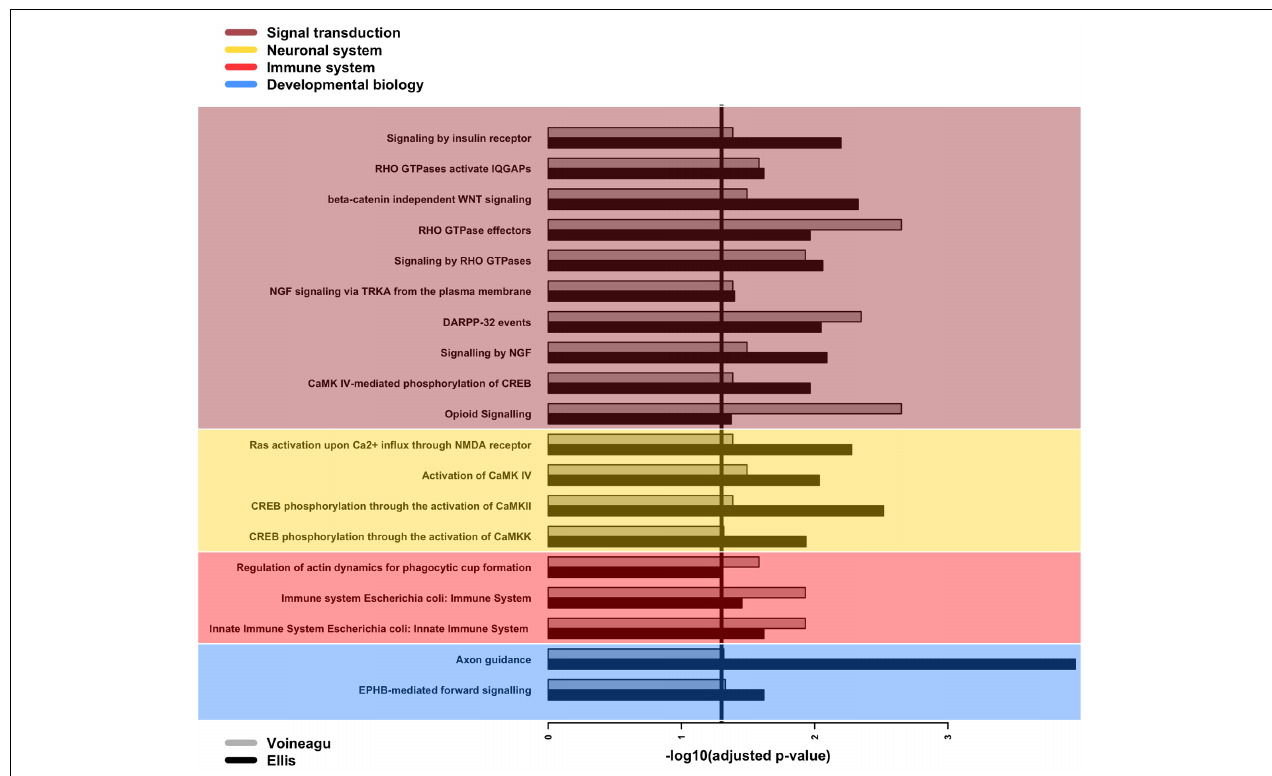
FIGURE 3 | GOseq enrichment of Reactome pathways among genes with differential APA events. Barplot of adjusted p -values for the enrichment of 19 Reactome pathways over-represented among genes with differential APA events in both Ellis and Voineagu datasets. The pathways have been grouped according to their main classification within Reactome, with signal transduction being the most commonly occurring classification. The vertical line indicates the chosen significance cut-off (adjusted p -value <